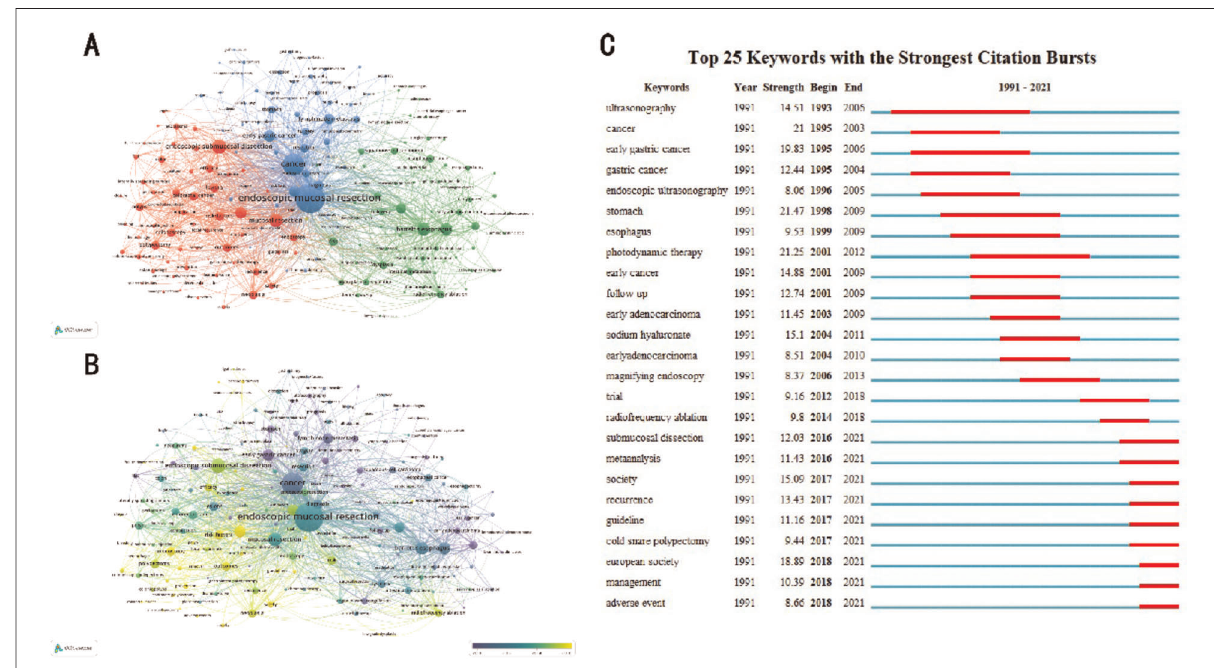
FIGURE 6 ( A,B ) The co-occurrence map based on keywords. ( C ) The top 25 keywords with the strongest citation bursts.